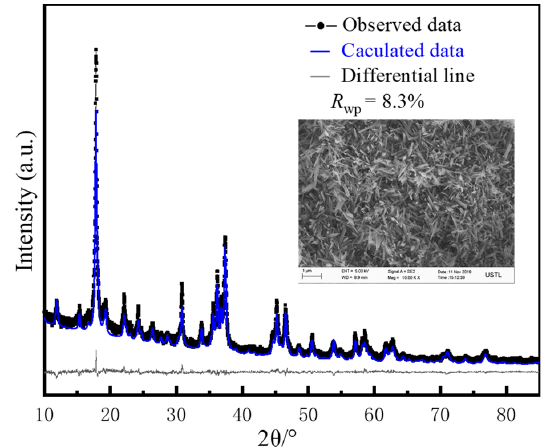
Figure 2. Synthesized hardened slurry: Rietveld diagram obtained by X ‐ ray diffraction (XRD) and microstructure observed by SEM.